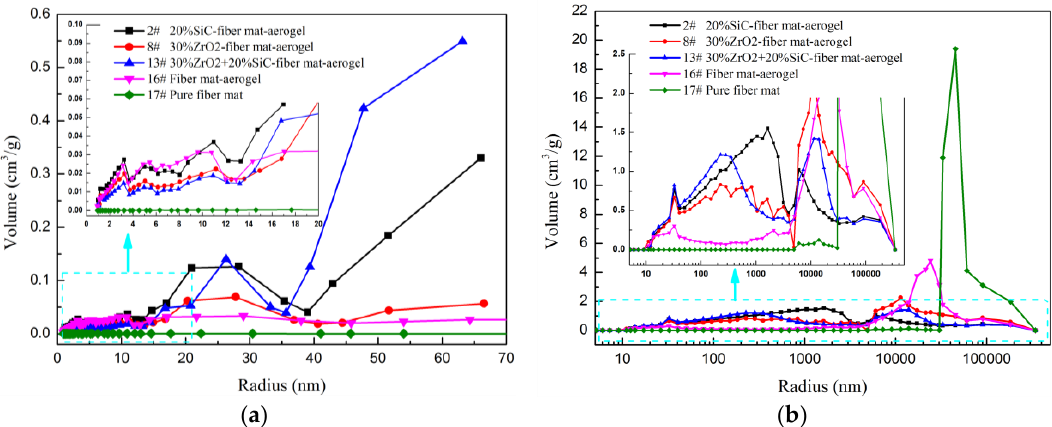
Figure 6. Pore size distribution of different materials. ( a ) Measured by Nitrogen adsorption; ( b ) Measured by Mercury injection.